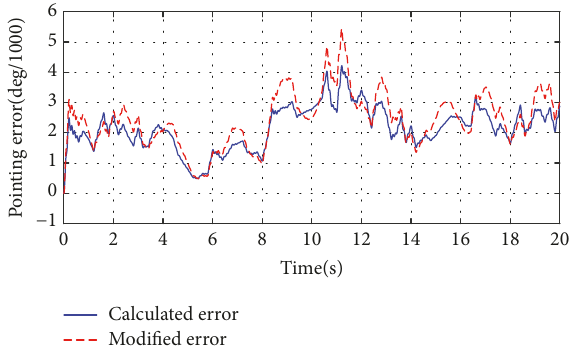
Figure 14: The comparison of pointing error before and after the